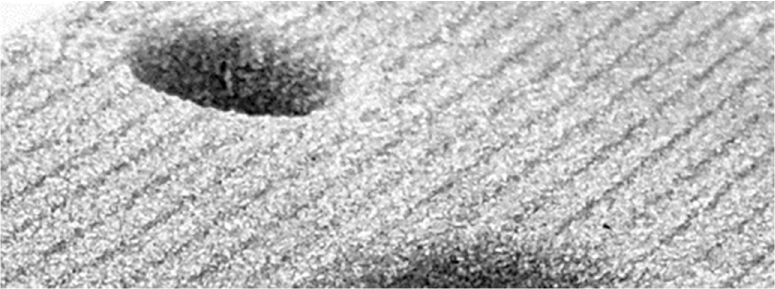
Figure 1. Stair-step e ff ect in a sand core produced via binder je tt ing.